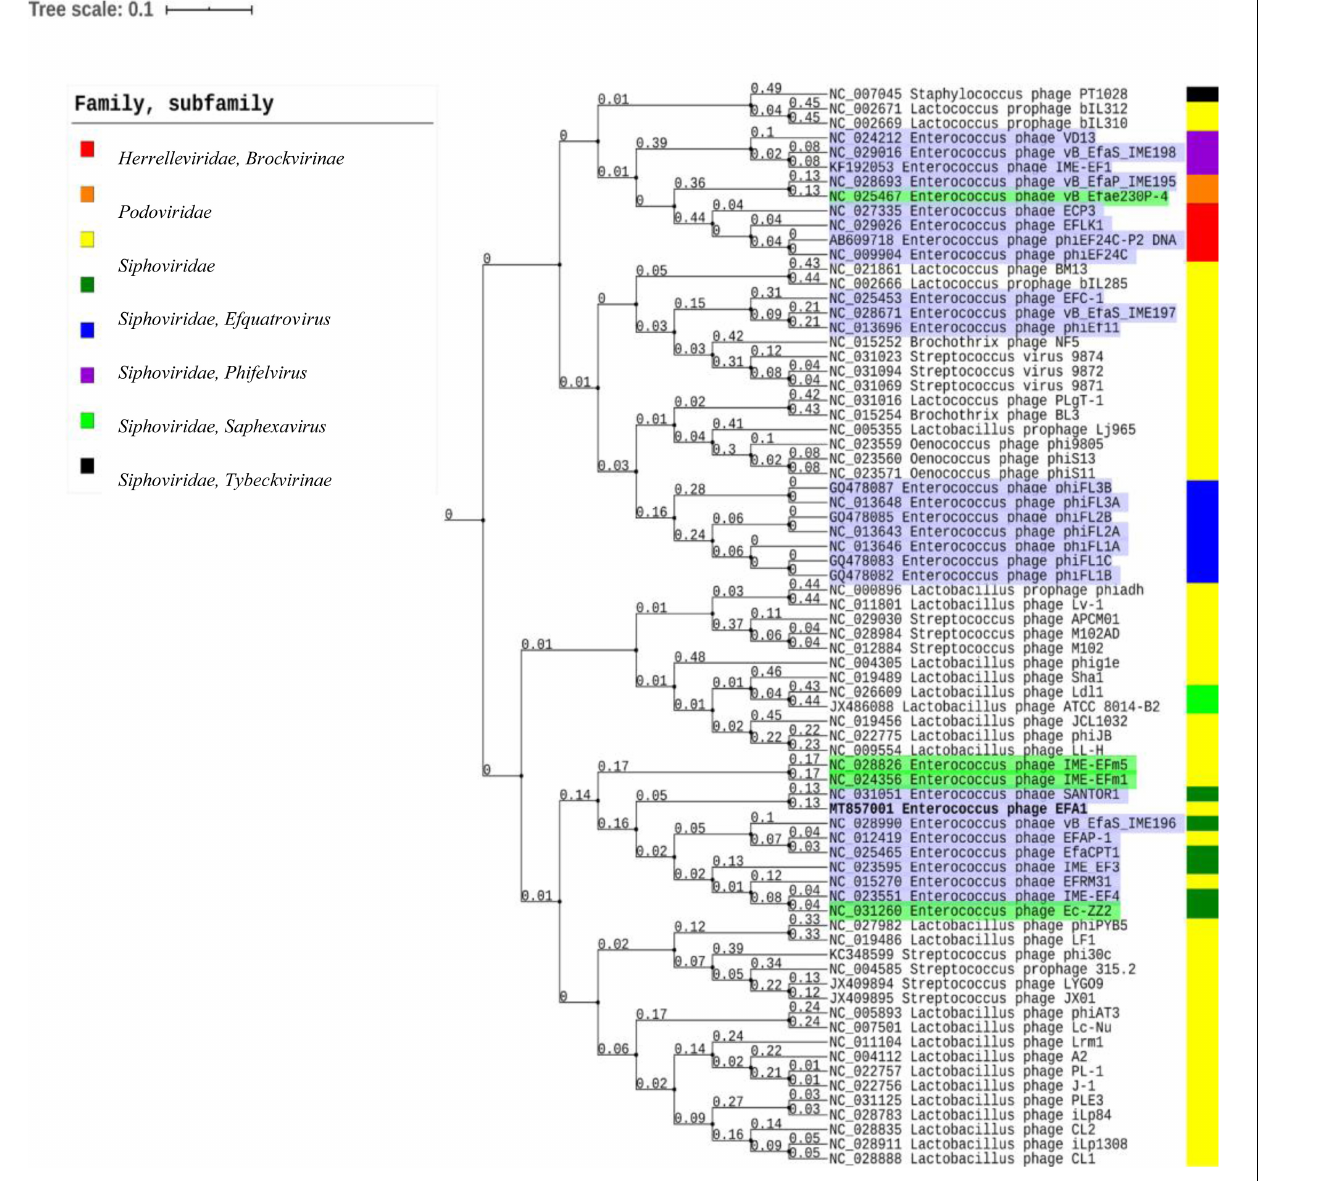
FIGURE 4 | Proteomic tree showing the genome-wide proteomic diversity between bacteriophage EFA1 (highlighted in bold font) and related bacteriophage genomes. Bacteriophages targeting E. faecalis are highlighted in purple while those targeting E . faecium are highlighted in green. Color coded bar represents the family and subfamily of the bacteriophage (key is at top